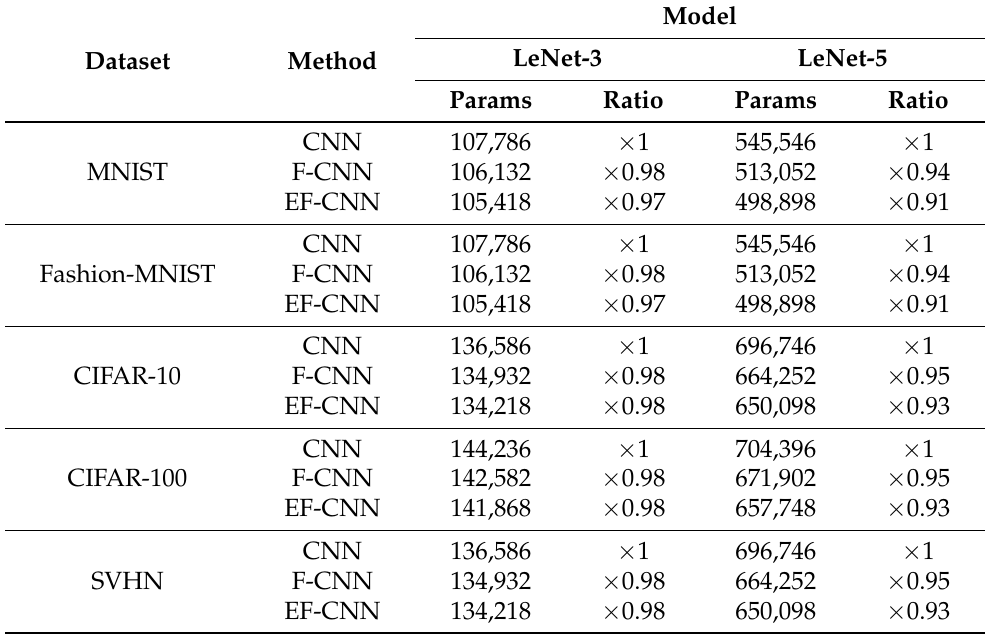
Table 9. The total number of trainable parameters for CNN, Fourier CNN and efficient Fourier CNN based on random